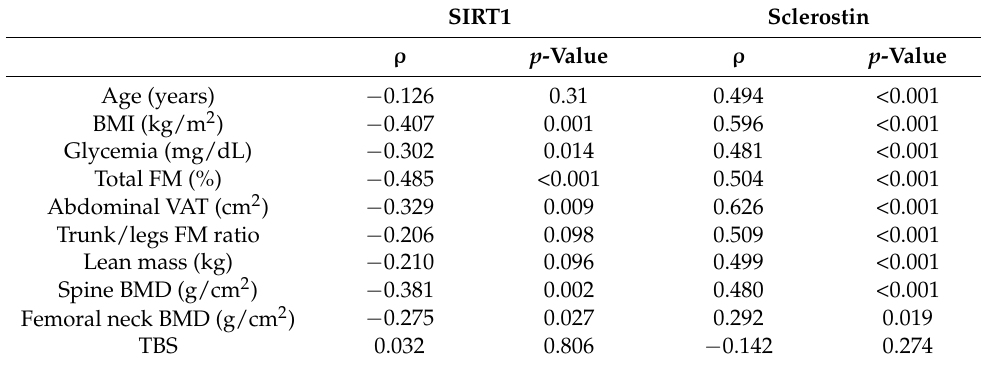
Table 2. Linear correlation analyses between SIRT1 and sclerostin and indicators under consideration.